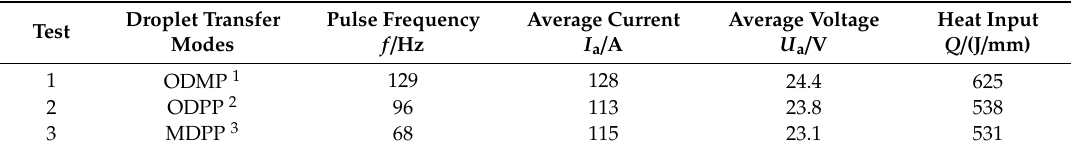
Table 3. The parameters of waveforms and